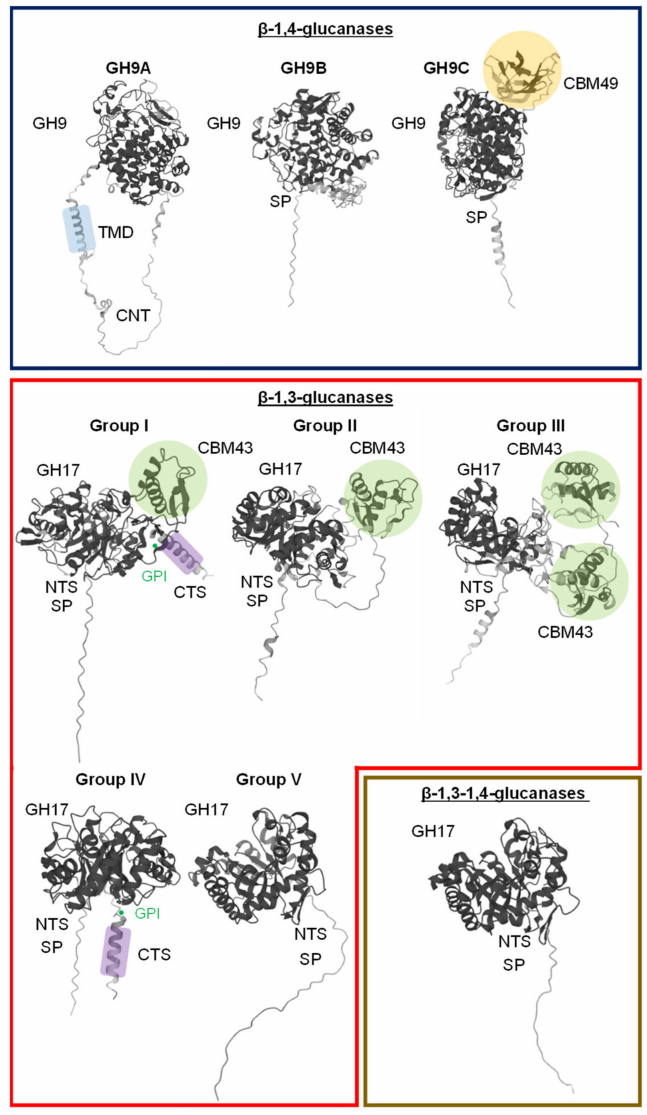
Figure 2. Topology models of plant β -glucanases. Protein domains and regions are abbreviated as follows: NTS—N-terminal sequence; GH—core glycosyl hydrolase family domain; CBM—carbohydrate binding module; GPI—glycosylphosphatidylinisotol-anchor attachment; CTS—hydrophobic C-terminal sequence; CNT—cytosolic N-terminal extension; SP—secretory signal peptide; TMD—transmembrane domain. Structure models represented in this figure were built by using the AlphaFold Protein Struc- ture Database [40,41] with the following Uniprot accessions: GH9A 1,4- β -glucanase (AtGH9A1; Q38890), GH9B 1,4- β -glucanase (AtGH9B16; Q9SVJ4) and GH9C 1,4- β -glucanase (AtGH9C1; Q9M995), group I 1,3- β -glucanase (At5g64790; Q9LV98), group II 1,3- β -glucanase (At2g05790; F4IHD3), group III 1,3- β -glucanase (At2g39640; O48812), group IV 1,3- β -glucanase (At1g77780; Q9CA16), group V 1,3- β -glucanase (At5g20340; O49353), 1,3;1,4- β -glucanase (ZmMLGH1;